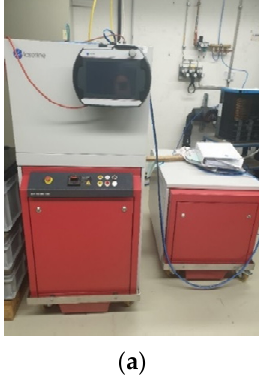
Figure 8 . Laserline LDF 20000-200: ( a ) laser machine; ( b ) Zoom laser optic below the vacuum ves- sel; ( c ) laser spot size 19 × 19 mm 2 .